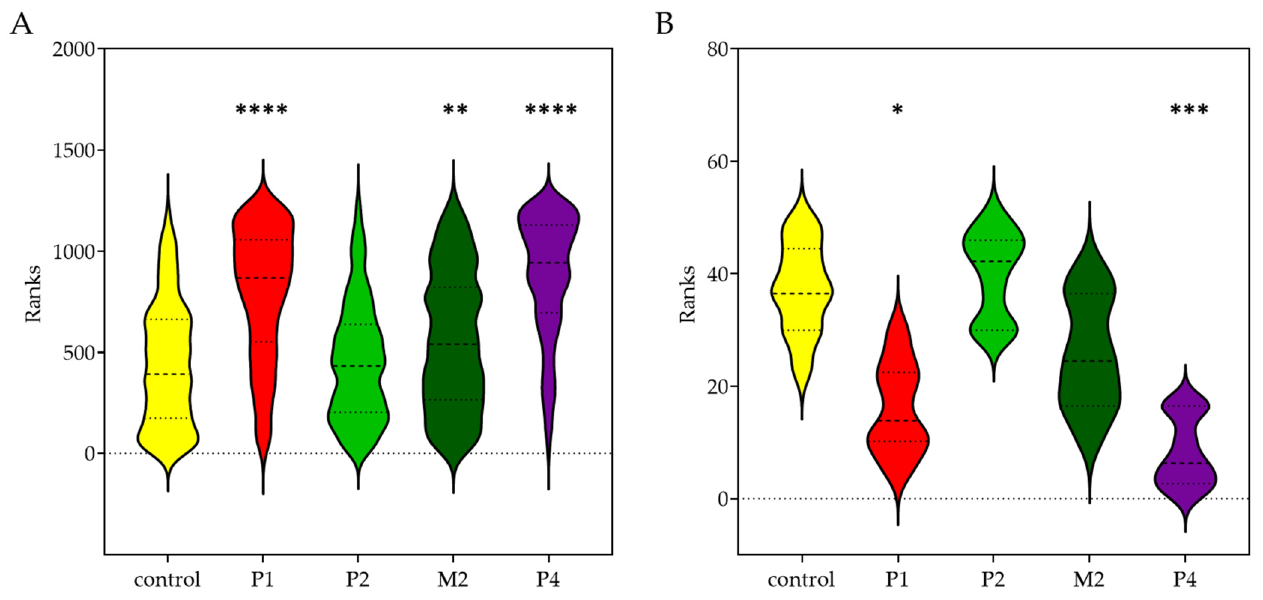
Figure 3. Violin plots represent the results of ( A ) fiber thickness measurement, where the patient samples were compared to control. The Kruskal–Wallis test revealed significant difference in P1 (****; control vs. P1, p < 0.0001), M2 (**; control vs. M2, p = 0.011), and P4 (****; control vs. P4, p < 0.0001). The fiber thickness of P2 was comparable to controls (control vs. P2, p > 0.9999). ( B ) average no. of fibers per 1 µ m 2 measurement, where the patient samples were compared to control. The Kruskal–Wallis test revealed significant difference in P1 (*; control vs. P1, p = 0.0306) and P4 (***; control vs. P4, p = 0.0009). P2 (control vs. P2, p > 0.9999) and M2 (control vs. M2, p = 0.6654) had a comparable no. of fibers to controls. Abbreviations: P1: patient 1; P2: patient 2; M2: mother of patient 2; P4: patient 4.